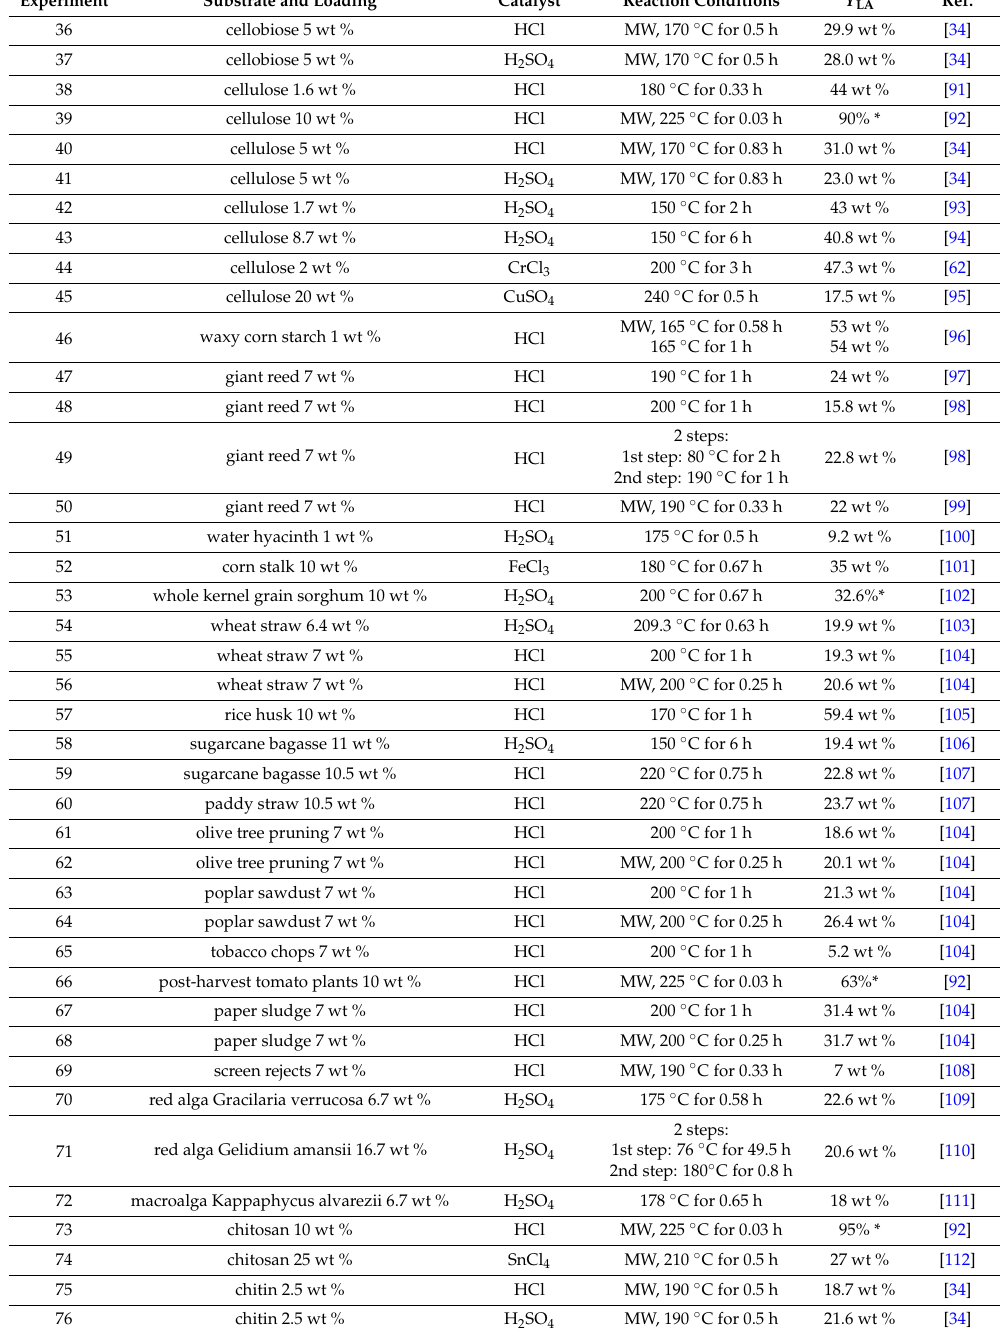
Table 4. Polysaccharides and raw and waste biomasses conversion in water in the presence of homogeneous catalysts: reaction